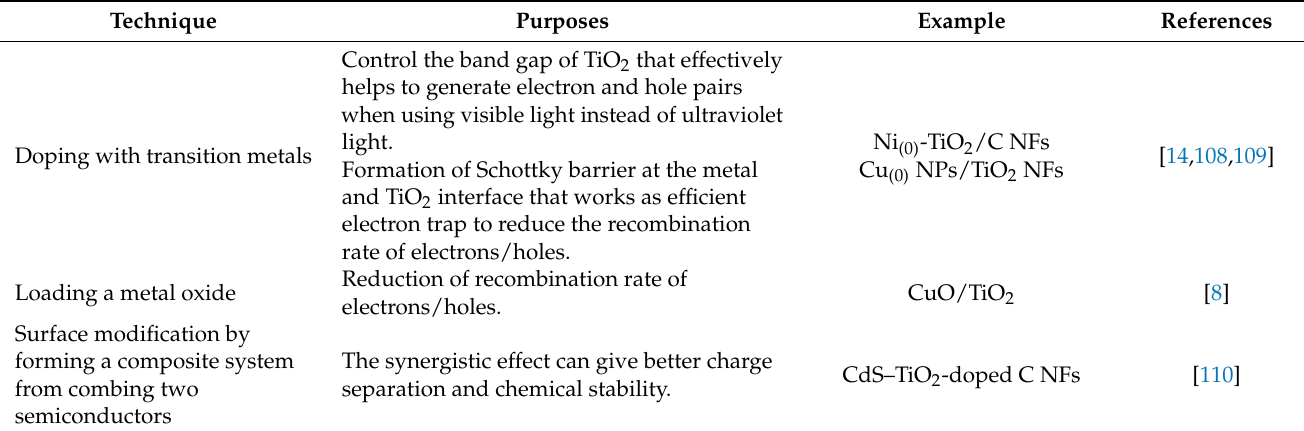
Figure 14. Effect of calcination temperature on TiO 2 crystallinity and surface area. Table 3. TiO 2 Modification